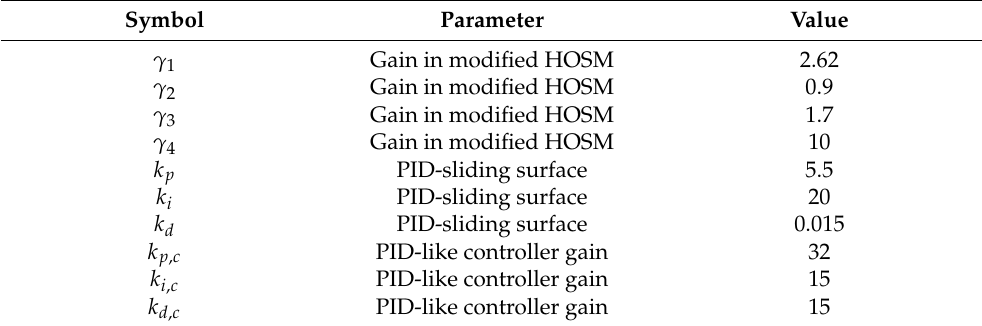
Table 2. Coefficients of controllers (14) and (26) used in the numerical and real-time simulations. Symbol Parameter Value γ 1 Gain in modified HOSM 2.62 γ 2 Gain in modified HOSM 0.9 γ 3 Gain in modified HOSM 1.7 Gain in modified HOSM PID-sliding surface